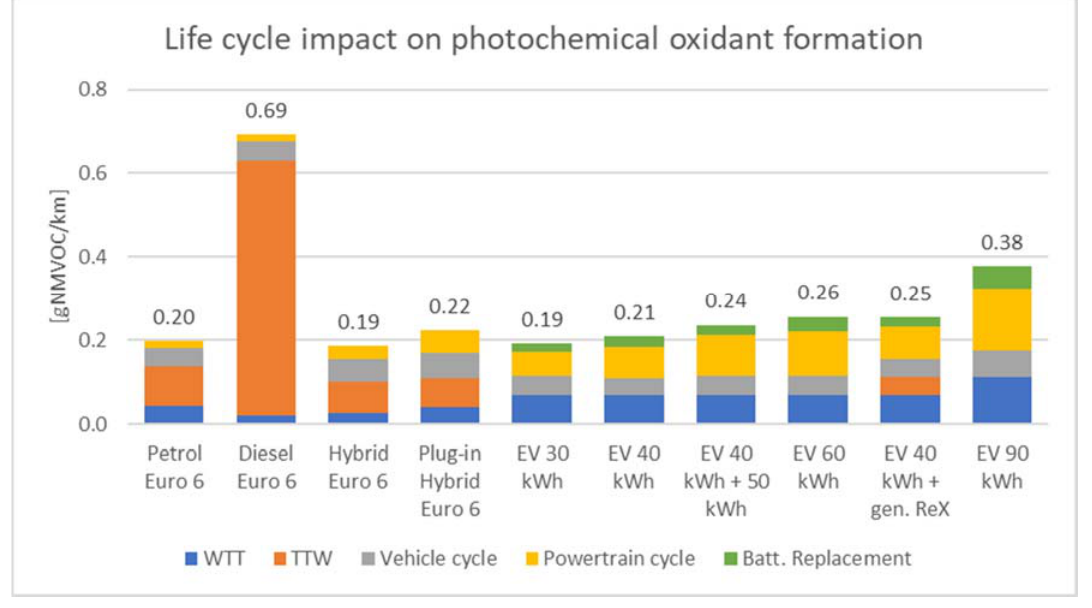
Figure 5. Impact per kilometer on photochemical oxidant formation.